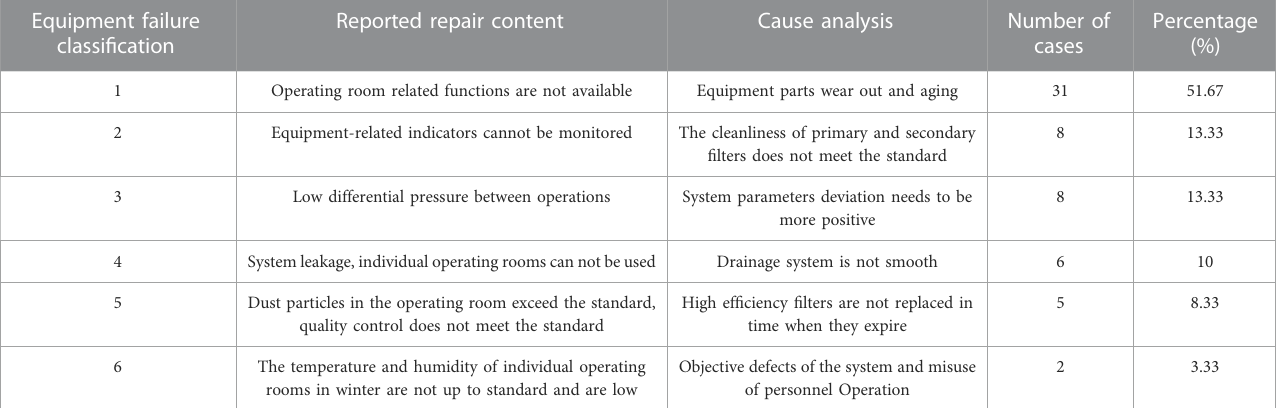
TABLE 1 Recent maintenance statistics of the operating